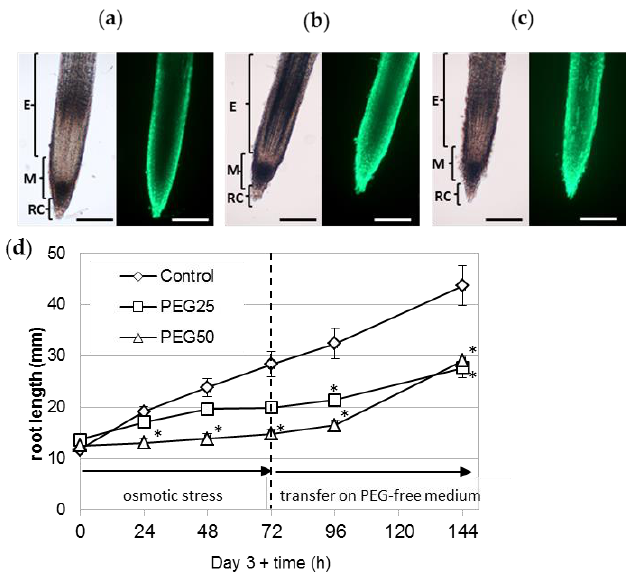
Figure 7. Survival of the root apical meristem under osmotic stress. The viability of the root tip (meristematic and elongating zones) of seedlings grown for 72 h under control conditions ( a ), moderate ( b , PEG25), and strong ( c , PEG50) osmotic stress was assessed using the FDA probe. The RET was removed beforehand, to facilitate observation of the root tip. Bar scale: 200 μm. E, elon- gation zone; M, meristematic zone; RC, root cap. ( d ) Recovery of stressed seedlings ’ root growth after transfer back to ½ MS control medium. After 72 h of osmotic stress, seedlings were transferred onto a fresh ½ MS control medium without PEG (mean and standard error of 10 roots from one biological replicate). * indicates significant difference with the corresponding control at level alpha = 0.05, according to a Kruskal – Wallis test with Dunn ’ s procedure. 3.5. Immunocytochemical Characterization of Glycopolymers in Control RET and Root Tip The occurrence of cell wall polysaccharides (pectins and hemicelluloses) and hy- droxyproline rich glycoproteins (arabinogalactan proteins and extensin) was investigated on resin-embedded longitudinal sections of root tips, using specific monoclonal anti- bodies (mAbs, see list Table S1 in Supplemental Data). For each antibody, we observed the fluorescence signal of the RET (mucilage and root associated cap-derived cells